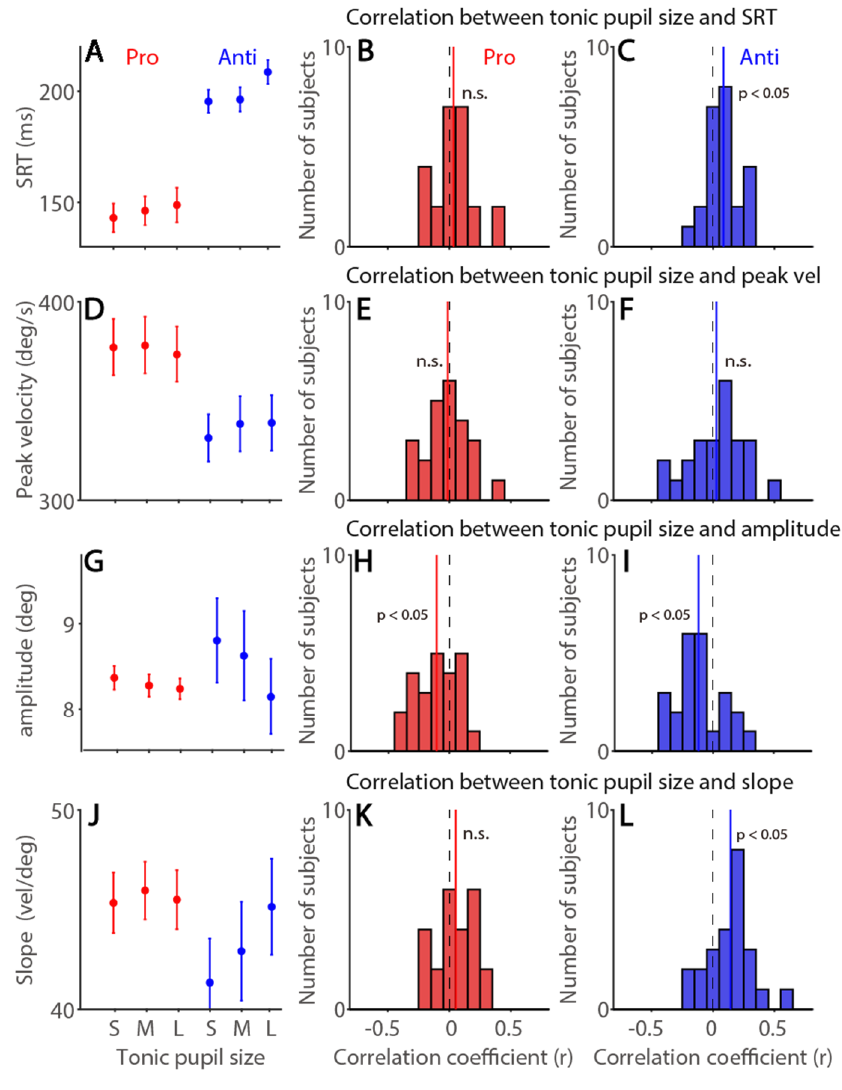
Figure 7. Tonic pupil size effects on saccade latency and metrics in the pro- and anti-saccade task. ( A ) Saccade reaction times (SRTs) at different tonic pupil size conditions. ( B , C ) Distribution of correlation coefficients for the relationship between tonic pupil size and SRT in the pro-saccade ( B ) and anti-saccade ( C ) task for all subjects ( n = 24). ( D ) Saccade peak velocity at different tonic pupil size conditions. ( E , F ) Distribution of correlation coefficients for the relationship between tonic pupil size and saccade peak velocity in the pro-saccade ( E ) and anti-saccade ( F ) task for all subjects. ( G ) Saccade amplitude at different tonic pupil size conditions. ( H , I ) Distribution of correlation coefficients for the relationship between tonic pupil size and saccade amplitude in the pro-saccade ( H ) and anti-saccade ( I ) task for all subjects. ( J ) Main sequence slope (peak velocity/amplitude) at different tonic pupil size conditions. ( K , L ) Distribution of correlation coefficients for the relationship between tonic pupil size and slope in the pro-saccade ( K ) and anti-saccade ( L ) task for all subjects. The error bars represent ± standard error range (across participants). The vertical black dashed line represents a zero value of the correlation coefficient (r = 0), and the vertical colored line represents the mean value of the correlation coefficient. Pro: pro-saccade task. Anti: anti-saccade task. S: small, M: mid, L: large. SRT: saccade reaction times. n.s.: not significant.